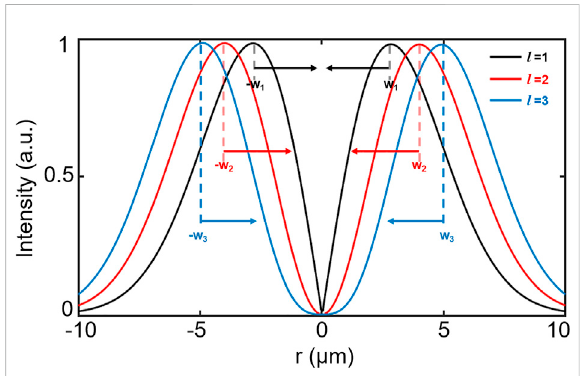
FIGURE 1 Pro fi les of LG laser intensity with topological l = 1, 2, and 3. The radius w 1 , w 2 , and w 3 correspond to the maximum light fi eld for the topological charge of l = 1, 2, and